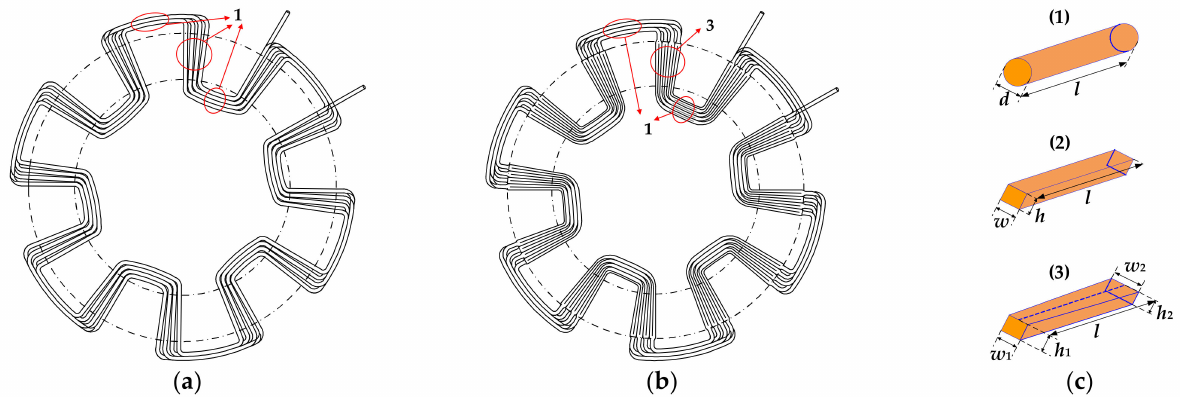
Figure 2. ( a ) Original coils; ( b ) optimized coils; ( c ) different wire types: ( 1 ) round conductor; ( 2 ) rectangular conductor; ( 3 ) wedge-shaped